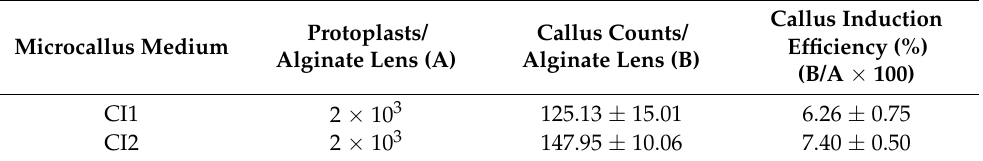
Table 5. Comparison of microcallus induction efficiencies between two different types of culture media (CI1 and